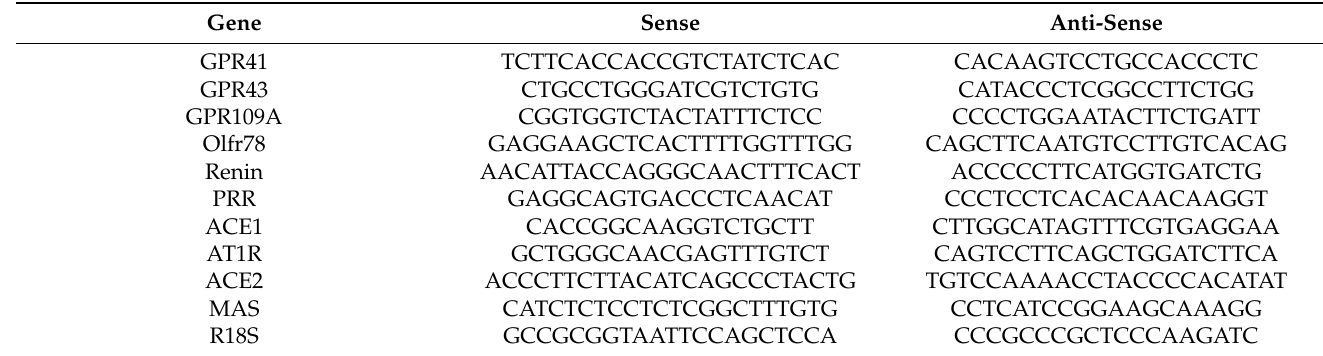
Table 1. Primer sequences used for real-time quantitative PCR (qPCR) analysis.